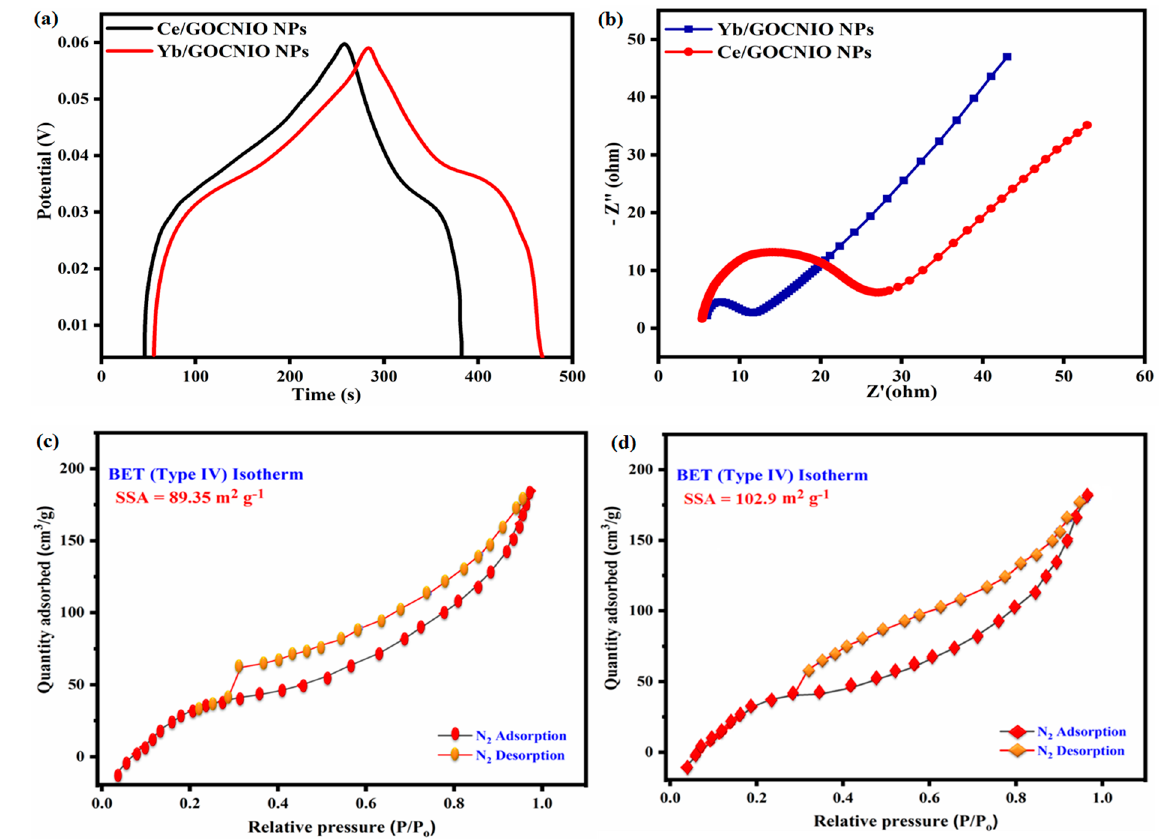
Figure 5. ( a ) GCD Profile of Ce/GOCNIO NPs and Yb/GOCNIO NPs; ( b ) EIS Nyquist Plots of Ce/GOCNIO NPs and Yb/GOCNIO NPs; ( c ) BET profile of Ce/GOCNIO NPs; ( d ) BET profile of Yb/GOCNIO NPs.